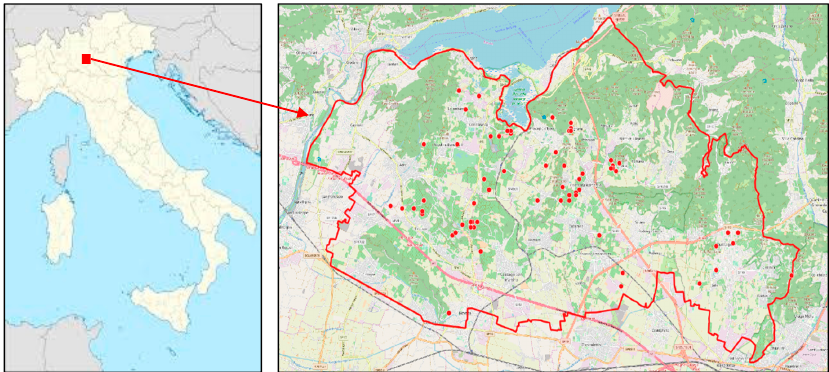
Figure 1. Map of the Franciacorta DOCG (Designation of Controlled and Guarantee Origin) winegrowing area. The locations of vineyards where samples were collected are indicated with red dots.